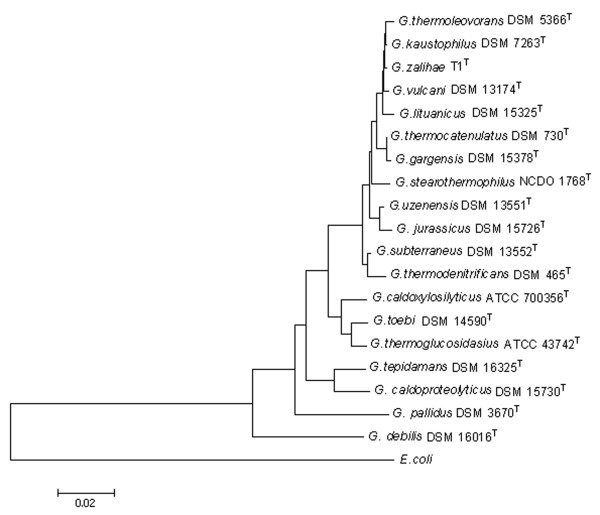
Phylogenetic position of Geobacillus zalihae T1T with other validly described species of the genus Geobacillus. The members of genus Geobacillus used include G. thermoleovorans (DSM 5366T); G. kaustophilus (DSM 7263T); G. vulcani (DSM 13174T); G. lituanicus (DSM 15325T); G. thermocatenulatus (DSM 730T); G. gargensis (DSM 15378T); G. stearothermophilus (NCDO 1768T); G. uzenensis (DSM 13551T); G. jurassicus (DSM 15726T); G. subterraneus (DSM 13553T); G. thermodenitrificans (DSM 465T); G. caldoxylosilyticus (ATCC 700356T); G. toebi (DSM 14590T); G. thermoglucosidasius (ATCC 43742T) G. tepidamans (DSM 16325T); G. caldoproteolyticus (DSM15730T); G. pallidus (DSM3670T); G. debilis (DSM16016T). Escherichia coli were used as an out-group. Phylogenetic tree was inferred by using the neighbour-joining methods. The software package MEGA 3.1 was used for analysis.